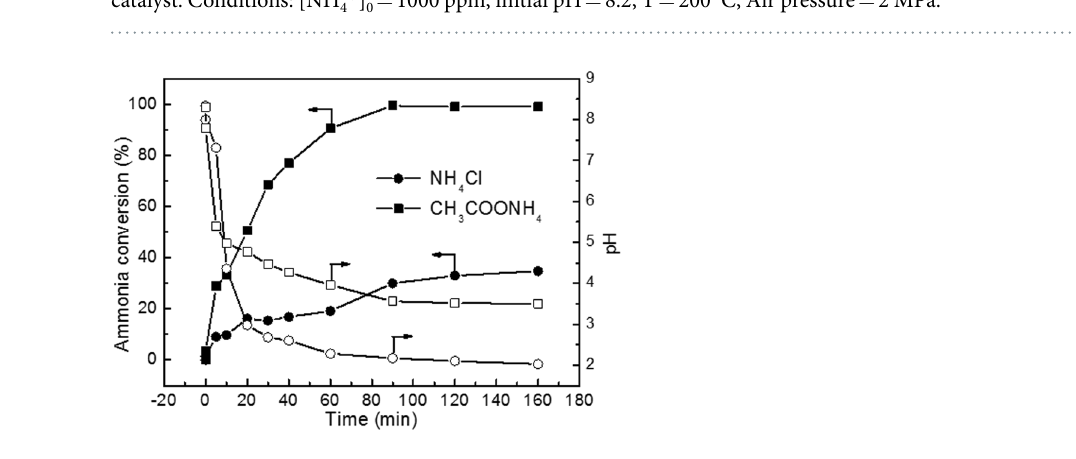
Figure 11. Evolutions of ammonia conversion and pH of NH 4 Cl and CH 3 COONH 4 solutions over Pt/TiO 2 catalyst. Conditions: [NH